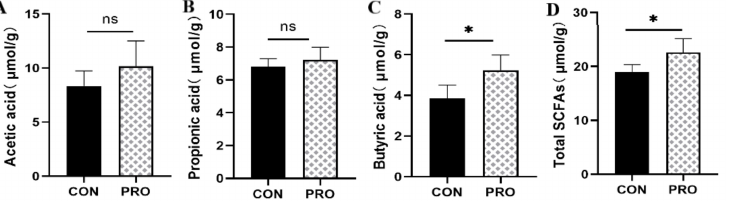
Figure 6. Effect of a multistrain probiotic preparation on fecal fermentation metabolites in healthy short-haired domestic cats. ( A – D ) Concentrations of acetic acid ( A ), propionic acid ( B ), butyric acid ( C ), and total SCFAs ( D ) detected by gas chromatography. Data are presented as mean ± SD. * p < 0.05; ns, p > 0.05 compared with the control